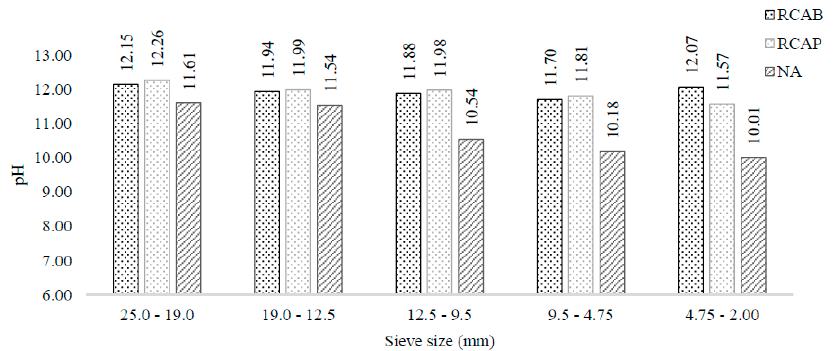
Figure 8. pH of NA, RCAP, and RCAB by particle size.